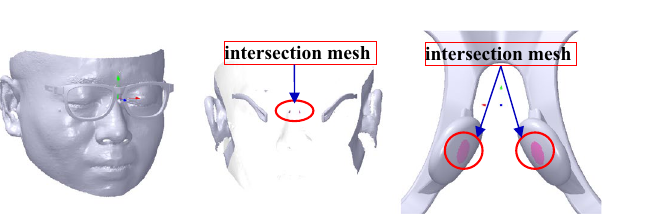
Figure 19. The rotation of the nose pad. From left to right: the front view, a partial enlarged and back view, a partial enlarged and back view without showing the face.